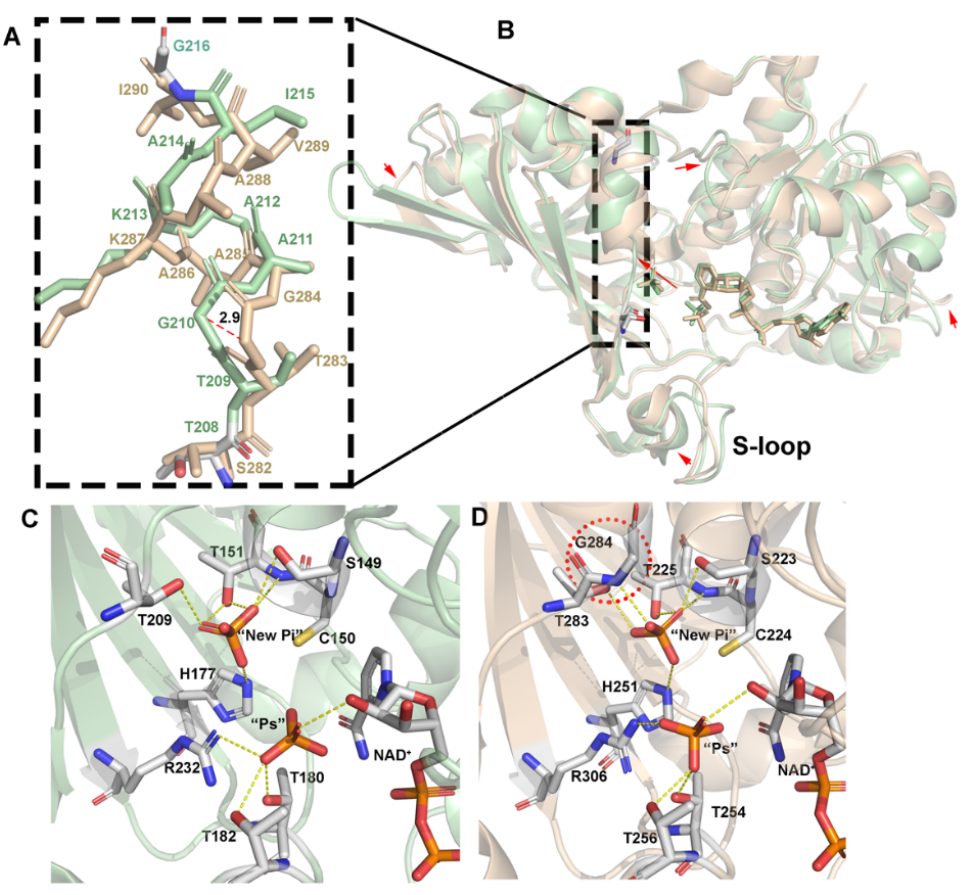
Figure 6. Phosphate binding of GAPDH in humans and bacteria. ( A , B ) Loop structure of ( C , D ) Phosphate- binding site from the R subunit of WT.NAD.PO4 (7C5H) and O subunit of Hs GAPDH